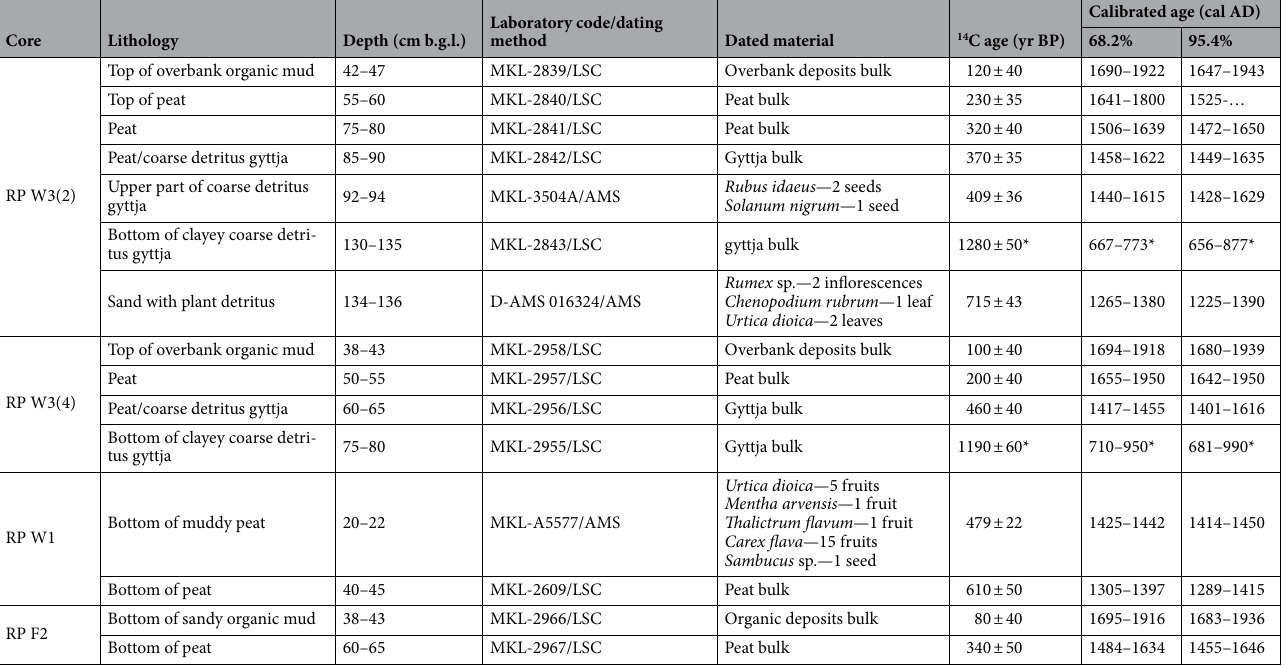
Table 1. The results of radiocarbon dating of the organic deposits of Rozprza moats. *Date recognised as outlier (redeposited material), not included in age-depth